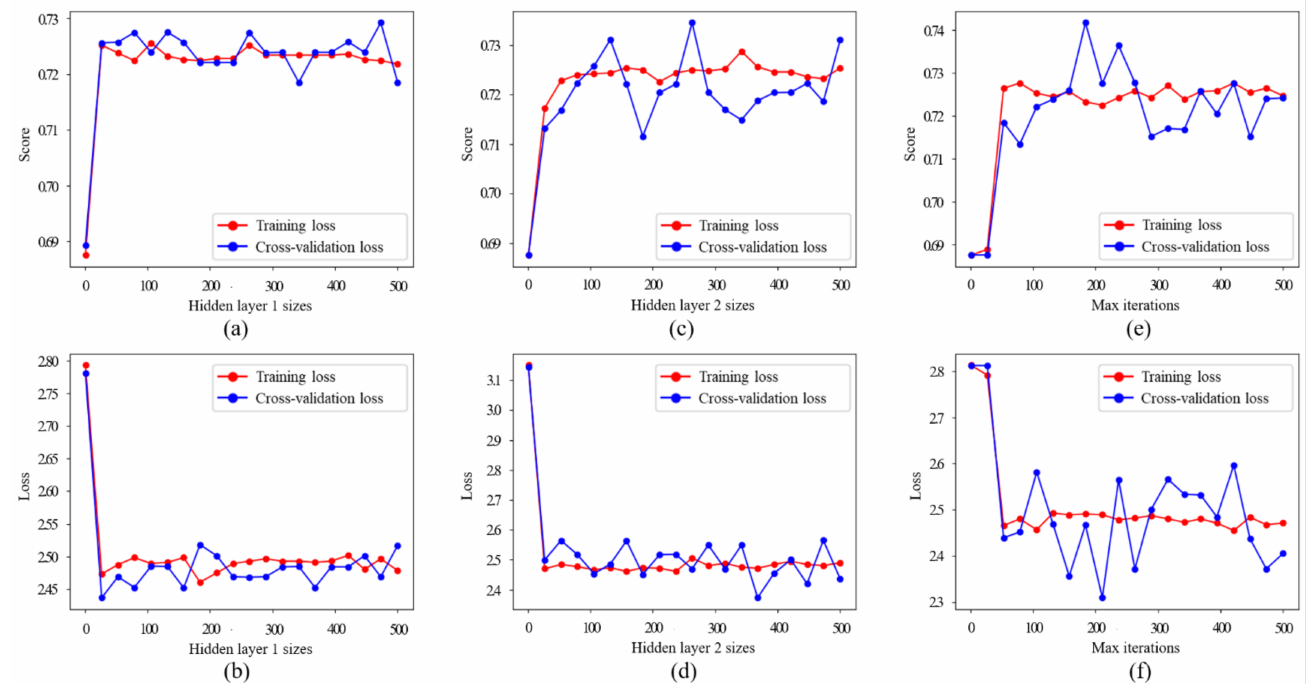
Figure 19. Verification curves of base learner hyperparameters. The ( a,b ) show the Score and Loss of Hidden layer 1 sizes. The ( c,d ) show the Score and Loss of Hidden layer 2 sizes. The ( e,f ) show the Score and Loss of Max